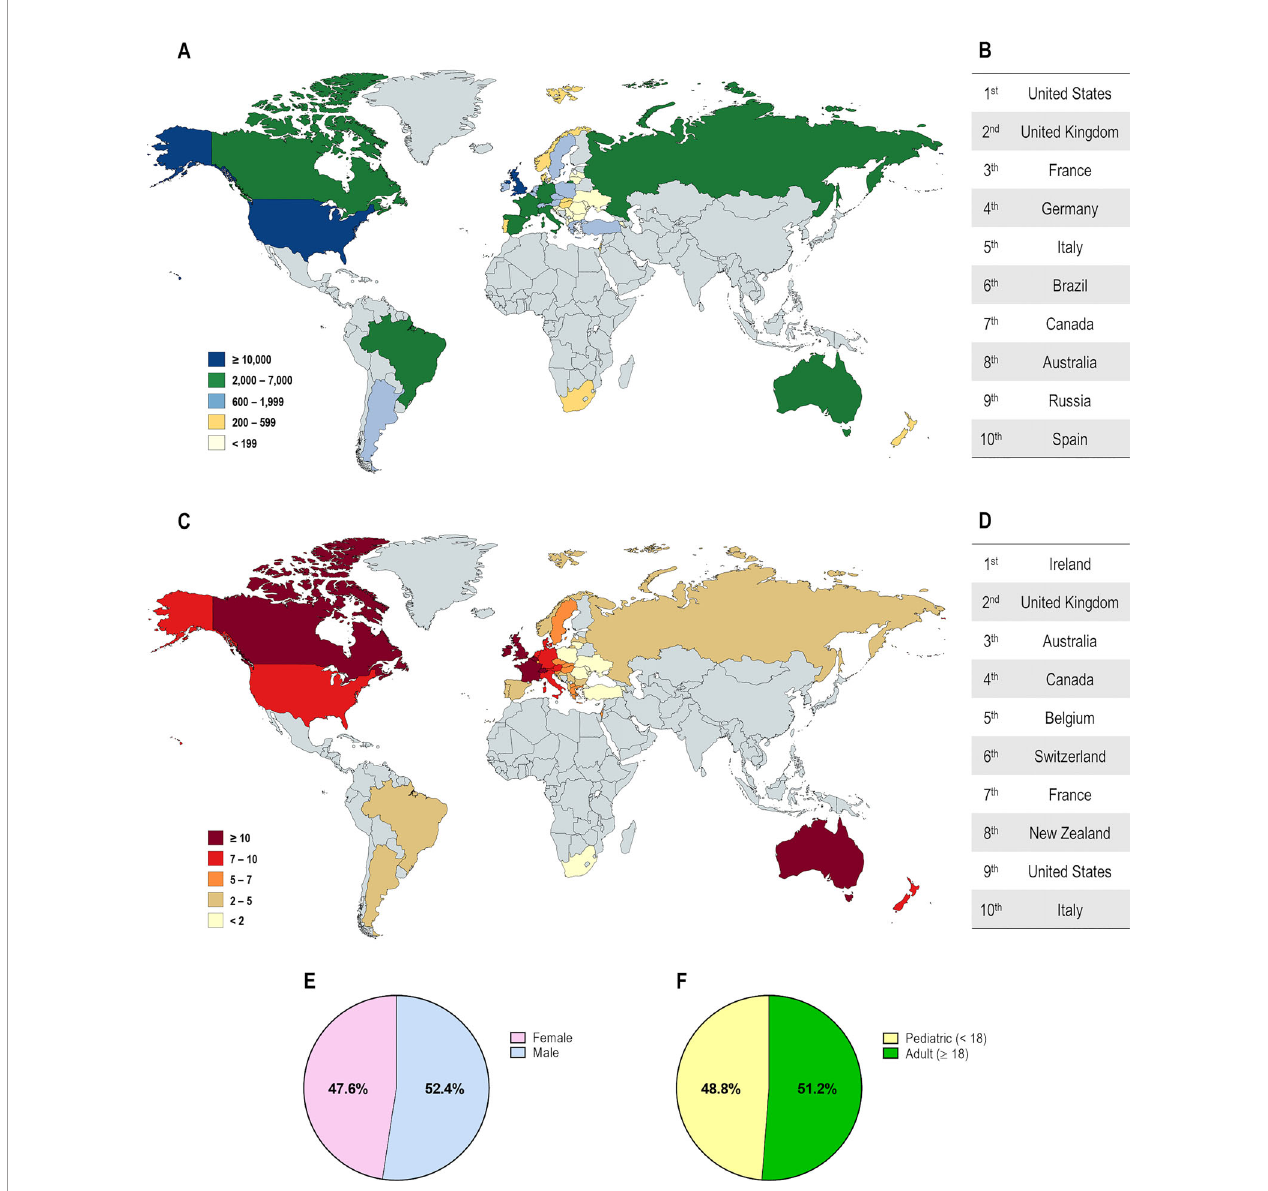
FIGURE 2 | Demography of cystic fi brosis patients in different countries. (A) Distribution according to the total number of patients registered. (B) Top 10 countries with the highest number of patients registered. (C) Distribution according to the estimated prevalence of patients per 100,000 habitants. (D) Top 10 countries with the highest number of patients per 100,000 habitants. Global distribution by gender (E) and by age (F) . [Data compiled from the last Patient Registry Report in Argentina (Pereyro et al., 2018), Australia (Cystic Fibrosis Australia, 2018), Brazil (Brazilian Cystic Fibrosis Study Group, 2019), Canada (Cystic Fibrosis Canada, 2019), Europe (European Cystic Fibrosis Society, 2019), New Zealand (Cystic Fibrosis New Zealand, 2019), South Africa (Zampoli et al., 2019), UK (Cystic Fibrosis Trust, 2019), and the USA (Cystic Fibrosis Foundation,